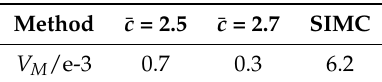
Table 9. Example 4. The table shows the comparison of the different settings for Algorithm 1 and SIMC using the main performance V M (Equation (42)).